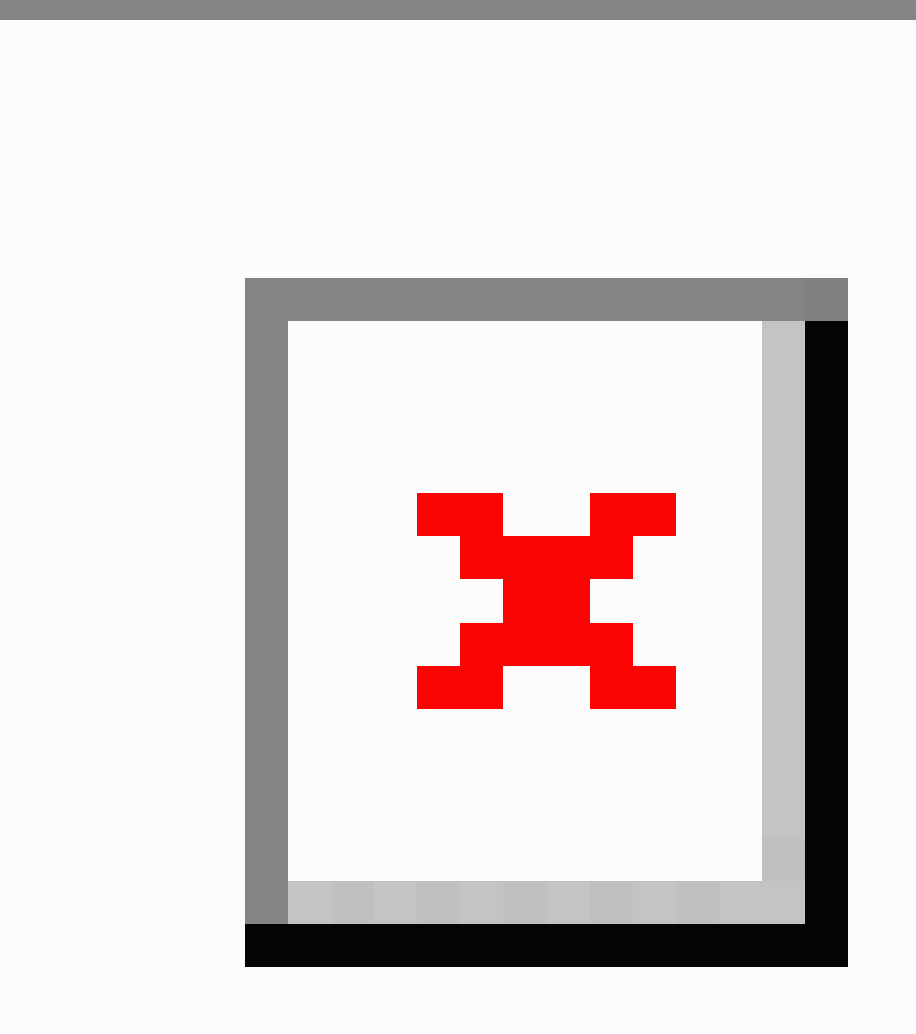
Figure 3. Generated distance matrix and identification of the set of